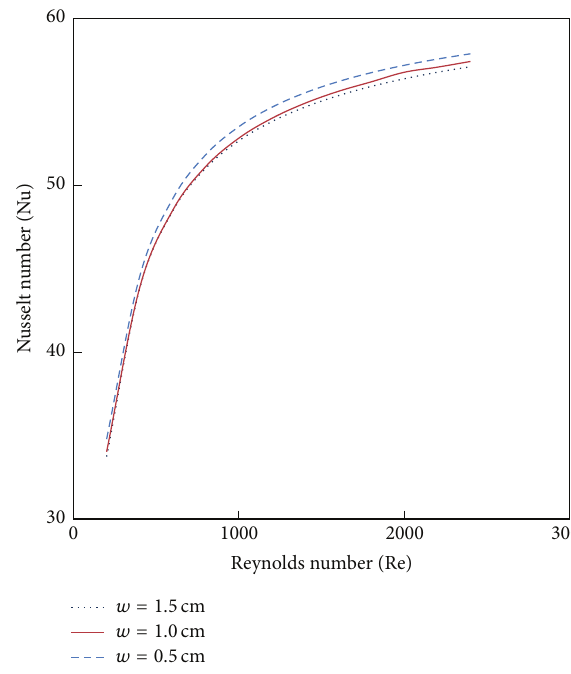
Figure 8: The effect of CuO nanofluid volume concentration on fiction factor for CCT of twist ratio 2.93. Figure 9: The effect of cut depth 4% CuO nanofluid on Nusselt